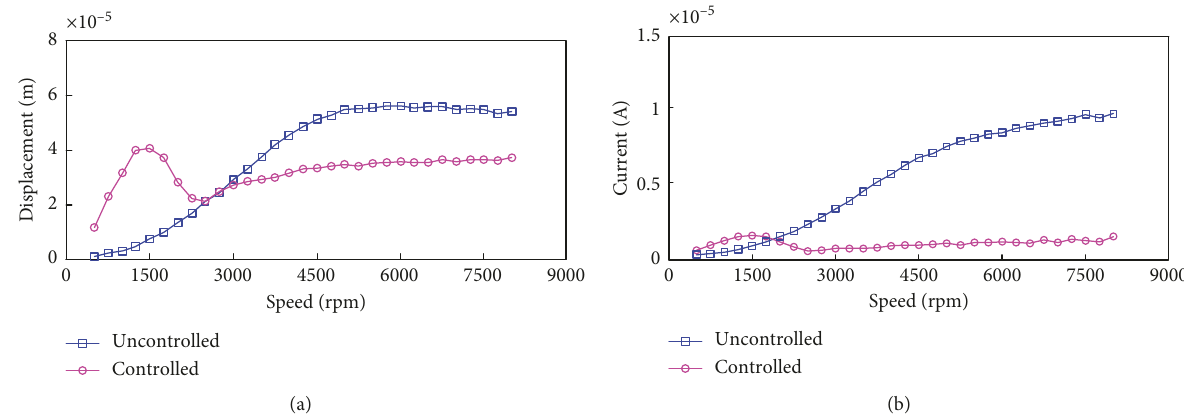
Figure 10: Comparison of vibration response at different speeds: (a) vibration displacement and (b) control